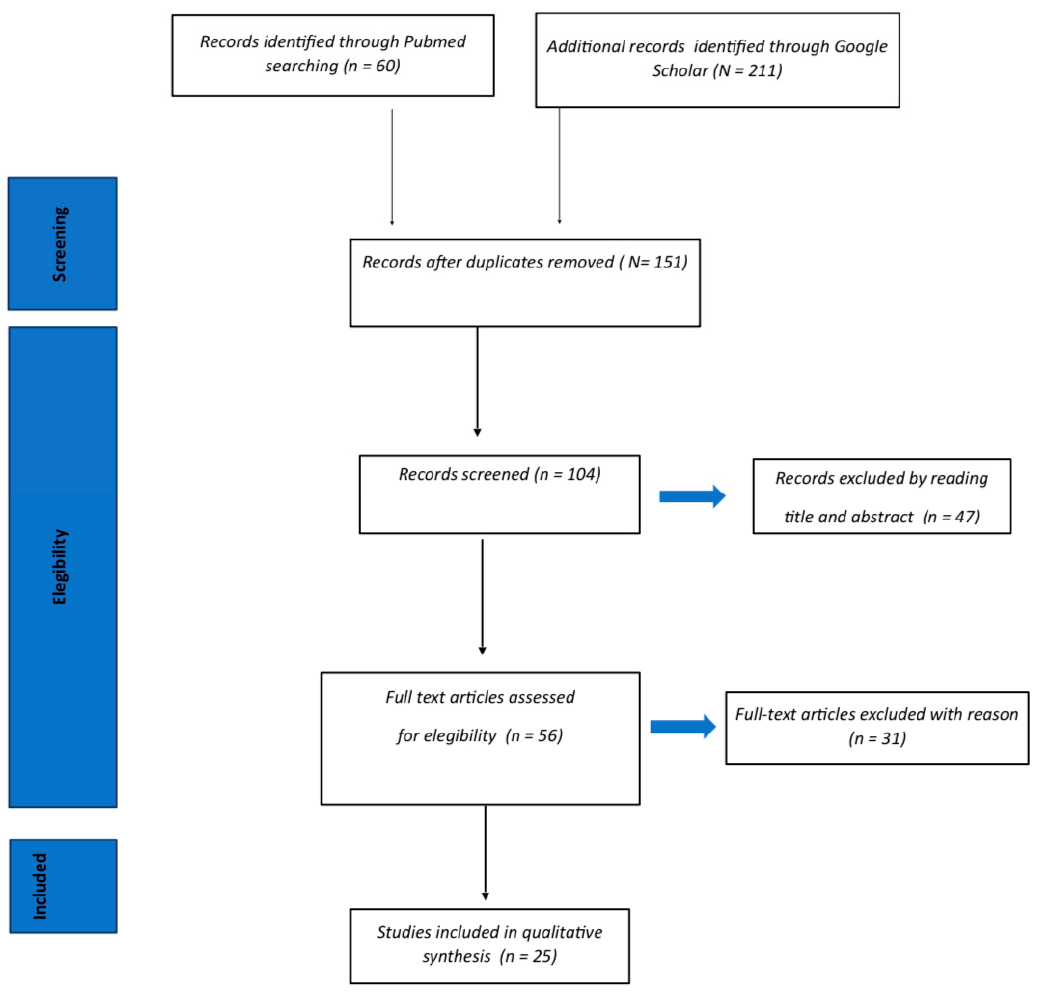
Figure 1. PRISMA (Preferred Reporting Items for Systematic Reviews and Meta-Analysis); flow diagram of the systematic review of the literature.